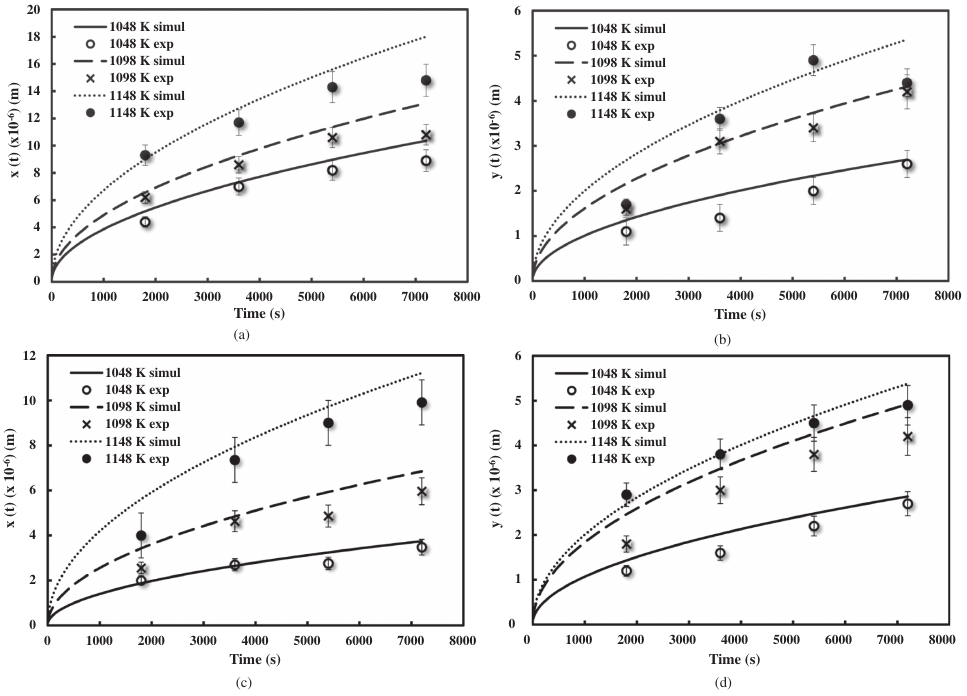
Figure 6: Evolution of CoB and Co 2 B layers as a function of the exposure time during the PBDCF: (a) and (b) surface exposed at the anode, (c) and (d) surface exposed at the